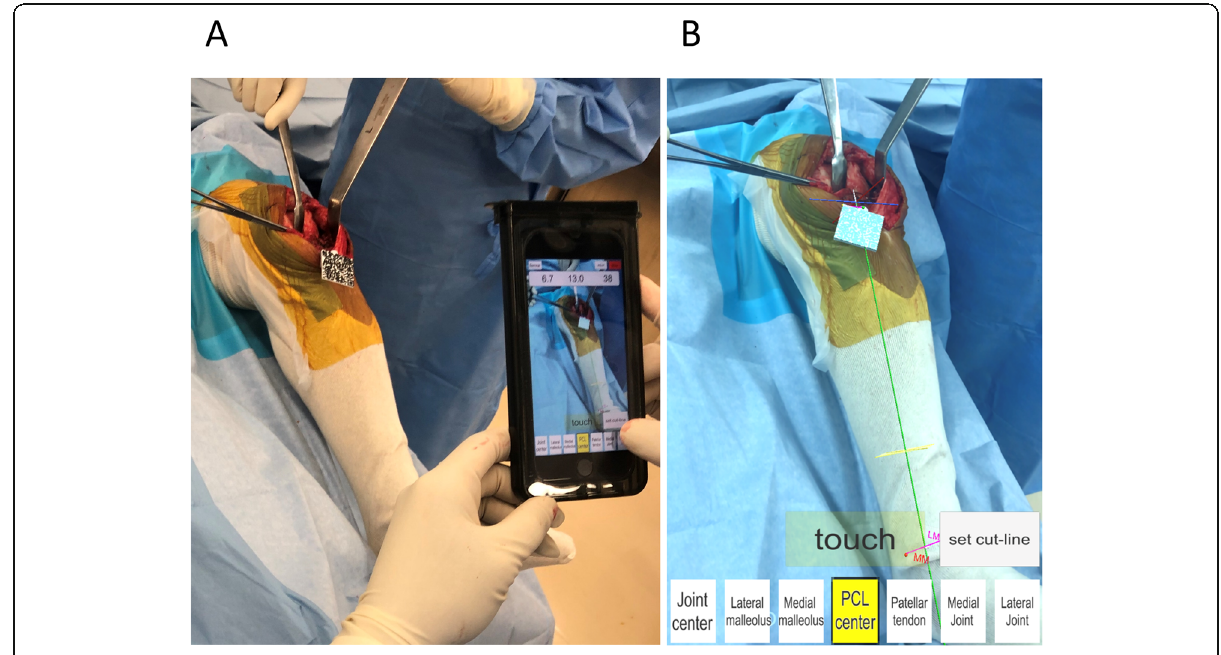
Fig. 1 Total knee arthroplasty using the AR-KNEE system. a The surgeon viewed the information superimposed on the surgical field through the screen of the smartphone in real time. Guide marker (resin marker with quadrate two-dimensional bar code) was fixed to the proximal tibia. The smartphone was placed in a sterilized case. b Screenshot image of ( a ). The tibial axis was superimposed on the patient ’ s lower leg (green line). When the smartphone camera recognized the two-dimensional bar code, the color of the marker guide turned light blue on the